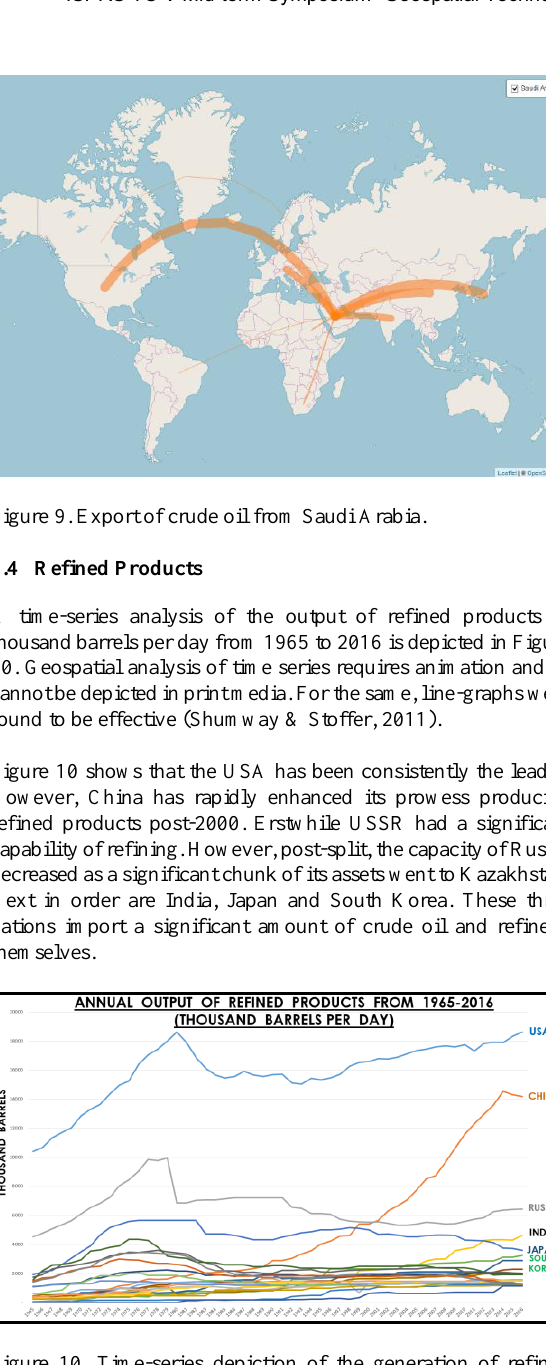
Figure 10. Time-series depiction of the generation of refined products from 1965 to 2016.